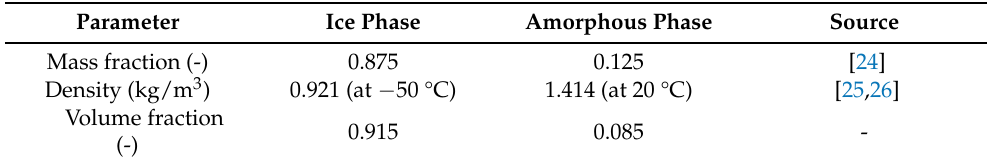
Table 1. Derived volume fractions of a maximum freeze-concentrated 10% ( w / w ) sucrose solution, based on published